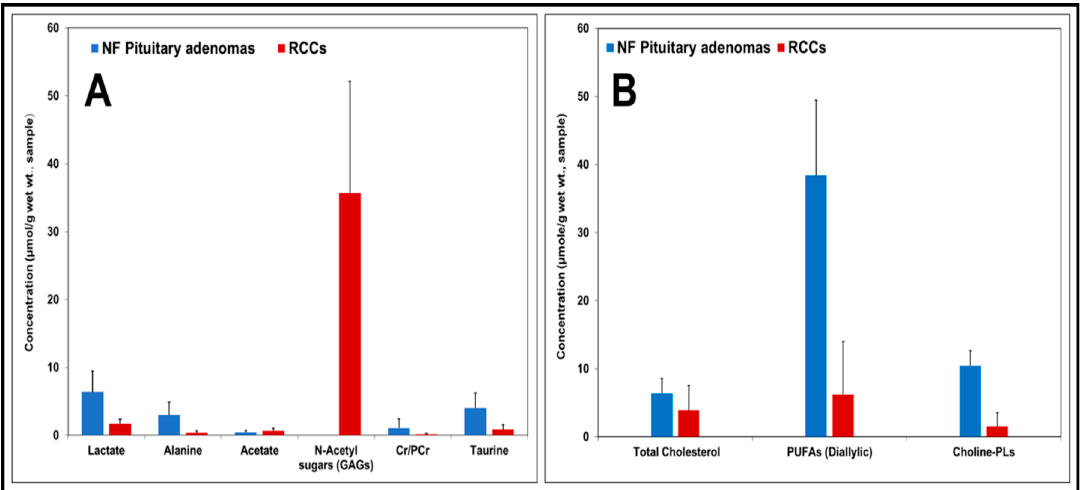
Figure 4. Representative 1 H NMR spectra of lipid extracts of NF pituitary adenoma and RCC. NF Pituitary adenoma shows the presence of cholesterol, cholesterol esters, PUFAs, glycerophosphoethanolamine (GPE), choline-containing phospholipids (Choline-PLs), sphingomyelin (SM), whereas RCCs showed the presence of mostly cholesterol and low levels of cholesterol esters, PUFAs and Choline-PLs. The asterisk (*) shows the presence of residual water in the NMR solvent, CDCl 3 .